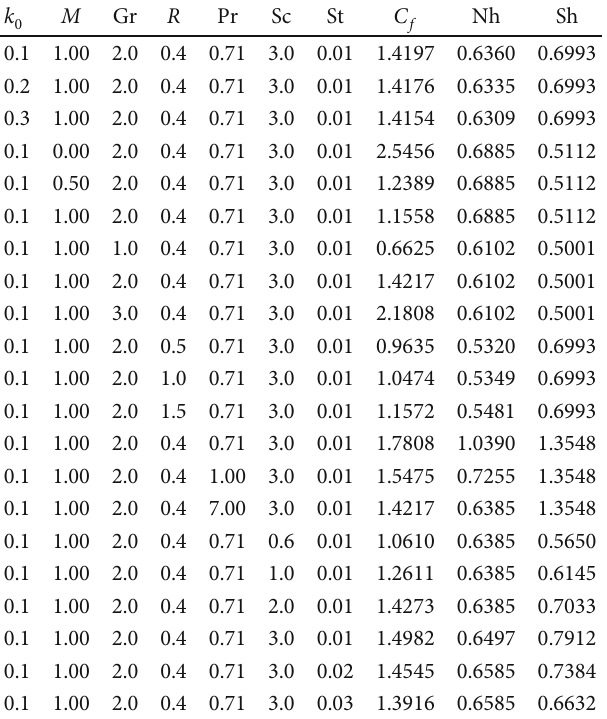
Table 2: Calculations of skin friction coe ffi cient ð C Nusselt number ð Nu Þ for di ff erent fl ow parameters. k 0